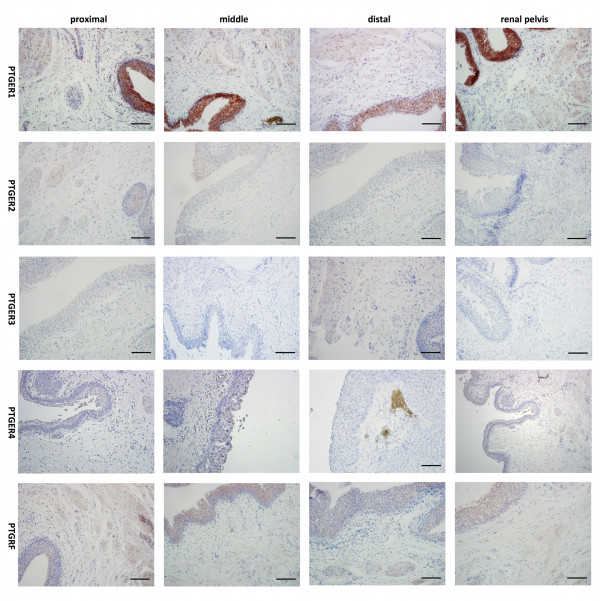
Representative staining of PTGER1-4 and PTGFR in the human ureter and renal pelvis.